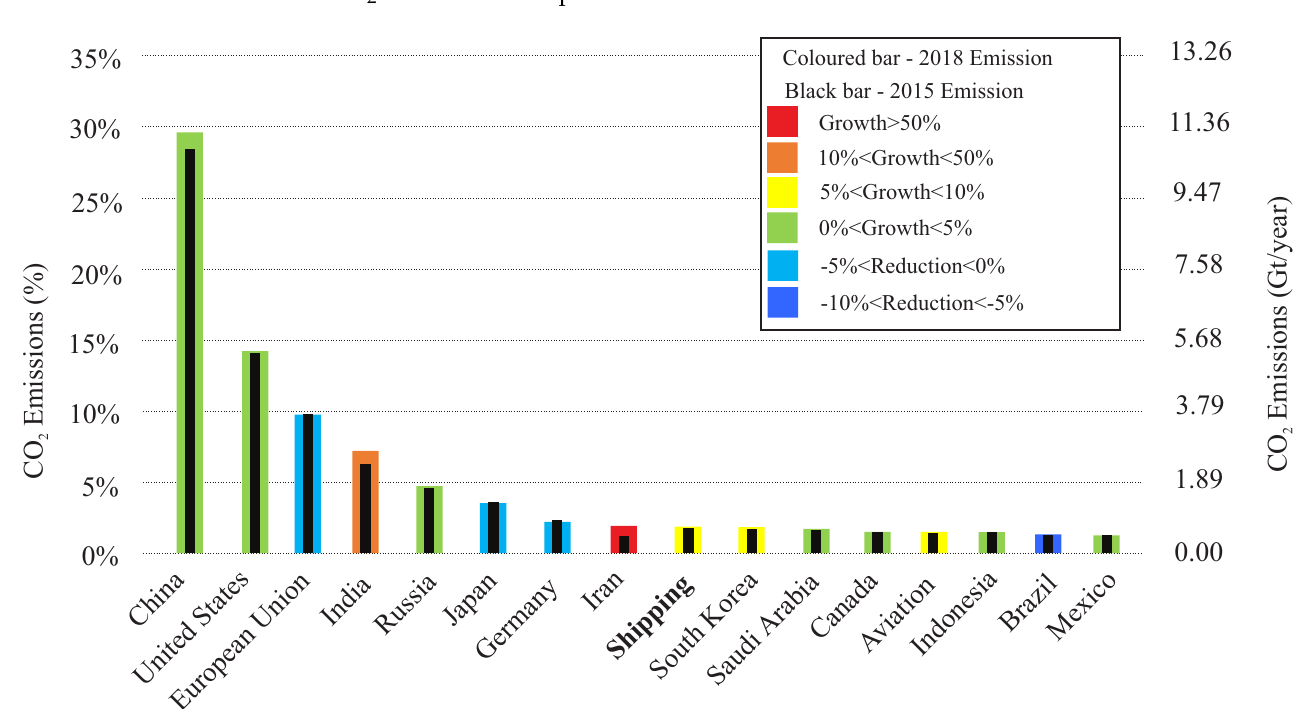
Figure 1. Global CO 2 emissions ranking comparing the emissions data from 2018 [3] with the data from 2015